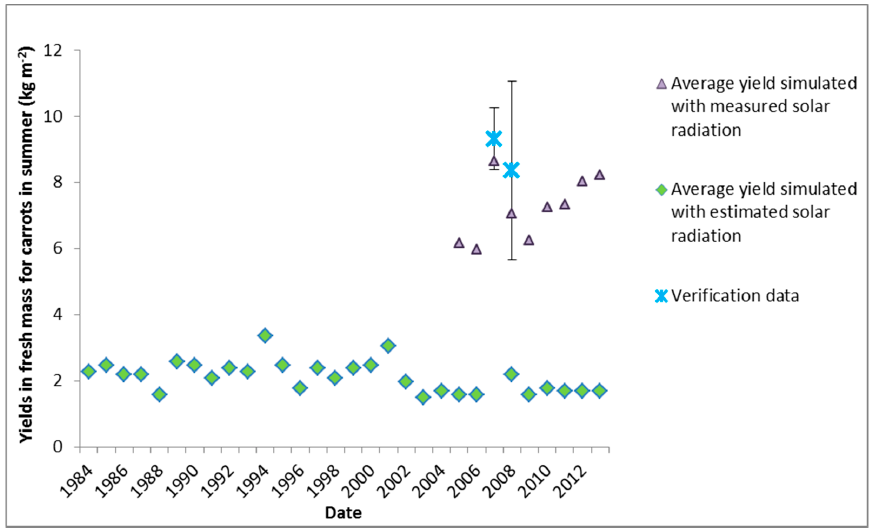
Figure 1. Soil Water Balance (SWB) model simulated yields versus actual yields of carrots grown in summer indicating the influence of using estimated versus measured solar radiation data on simulated yield results with standard deviations shown as error bars. Water 2016 , 8 , 473